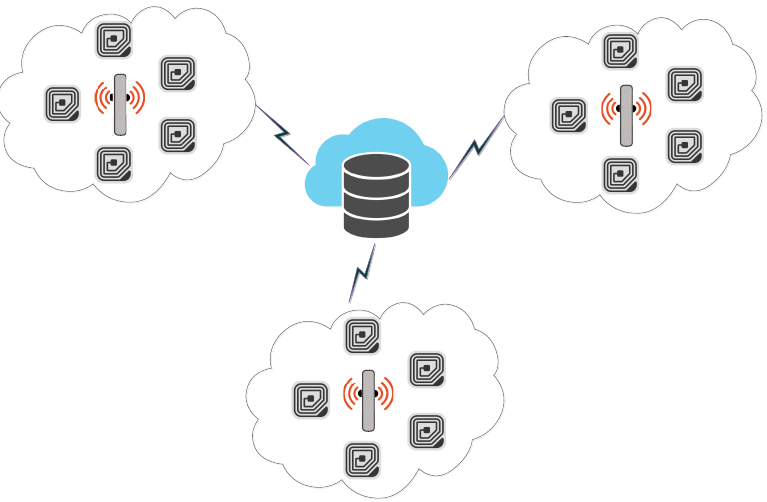
Figure 1. Radio Frequency Identification (RFID) System Architecture.